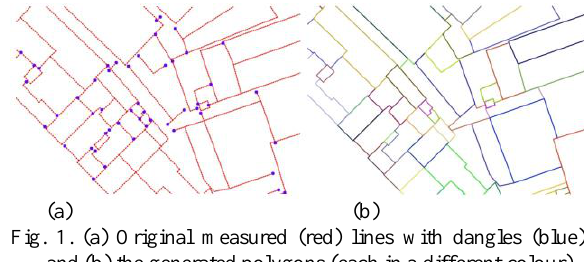
Fig. 1. (a) Original measured (red) lines with dangles (blue); and (b) the generated polygons (each in a different colour).